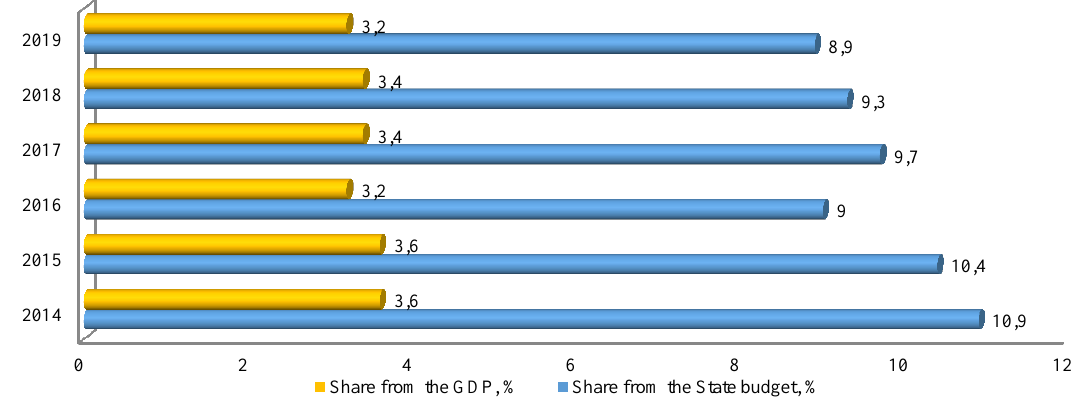
Fig. 2. Level of health expenditure in Ukraine in 2015 - 2019